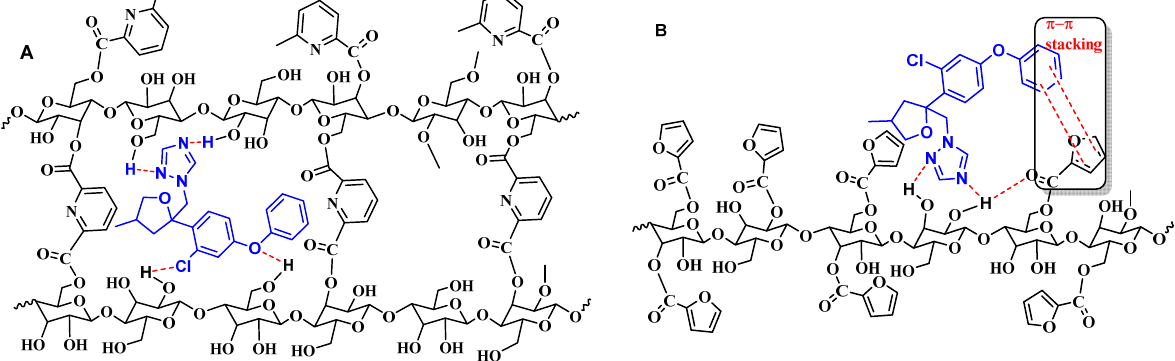
Figure 15. A representative structure shows the interaction between, ( A ) Cell-X and difenoconazole; ( B ) Cell-D and dif- enoconazole.